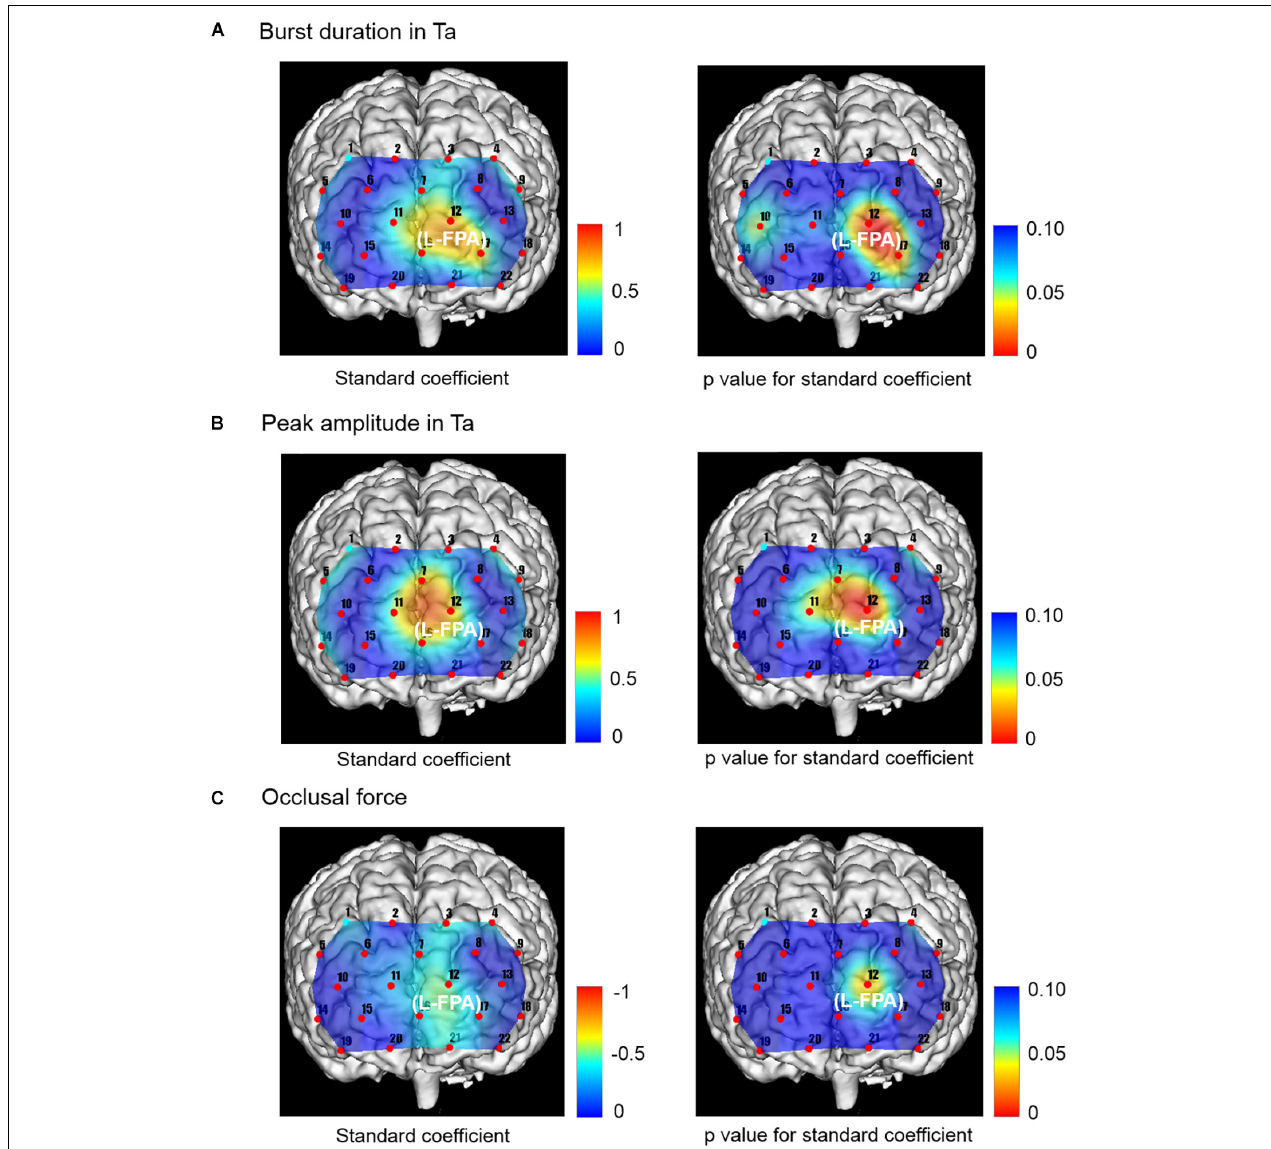
FIGURE 6 | Topographical maps showing standard coefficient and p values between independent variables of Ta muscle activities and occlusal force and prefrontal oxygenation hemoglobin concentration [(oxy-Hb)] of the dependent variable in right and left sides, respectively. (A) The change rates in burst duration in the Wearing condition were significantly and positively associated with the change rates in prefrontal [oxy-Hb] in L-FPA (CH 12). (B) The change rates in peak amplitude in the Wearing condition were significantly and positively associated with the change rate in prefrontal [oxy-Hb] during the chewing task in L-FPA (CH 12). (C) The change rate in occlusal force in the Wearing condition was significantly negatively associated with change rate in prefrontal [oxy-Hb] during the chewing task in L-FPA (CH